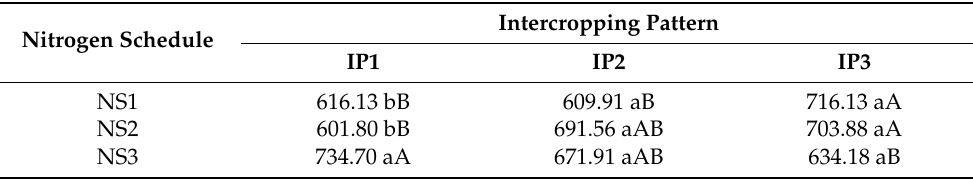
Table 2. Variations of the ear leaf area (cm 2 ) as affected by the interaction between the intercropping pattern and nitrogen schedule combined over the two growing